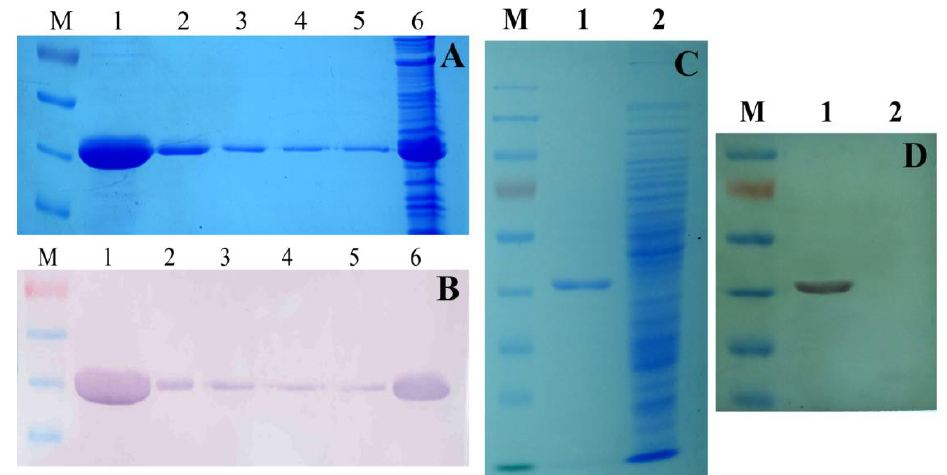
Figure 2. Analysis of the purified Tb -DdlA fusion protein by PAGE and Western blot. M, PageRuler prestained protein ladder (Fermentas), the sizes of the bands from top to bottom were 180 kDa, 130 kDa, 100 kDa, 70 kDa (red), 55 kDa, 40 kDa, 35 kDa, 25 kDa, and 15 kDa, respectively. ( A ) PAGE analysis of Tb -DdlA; 1–5, the elute fraction of Tb -DdlA fusion protein (with histidine tag) with an expected molecular weight of around 40 kDa purified by Ni 2+ -NTA affinity chromatography; 6, cell lysate from E. coli BL21(DE3) harboring pCold- ddlA ; ( B ) Western Blot analysis of Tb -DdlA. The monoclonal anti-polyhistidine antibody at 1 to 5000 dilution was used to blot the expressed Tb -DdlA. The bands on the gel were visualized by BCIP/NBT solution; 1–5, the elute fraction of the Tb -DdlA fusion protein (with the histidine tag) with an expected molecular weight of around 40 kDa purified by Ni 2+ -NTA affinity chromatography; 6, cell lysate from E. coli BL21(DE3) harboring pCold- ddlA ; ( C ) PAGE analysis of purified Tb -DdlA; 1, purified Tb -DdlA; 2, cell lysate from E. coli BL21(DE3) harboring pColdII; ( D ) Western Blot analysis of Tb -DdlA. The monoclonal anti-polyhistidine antibody at a 1 to 5000 dilution was used to blot the expressed Tb -DdlA. The bands on the gel were visualized by BCIP/NBT solution; 1, purified Tb -DdlA; 2, cell lysate from E. coli BL21(DE3) harboring pColdII.